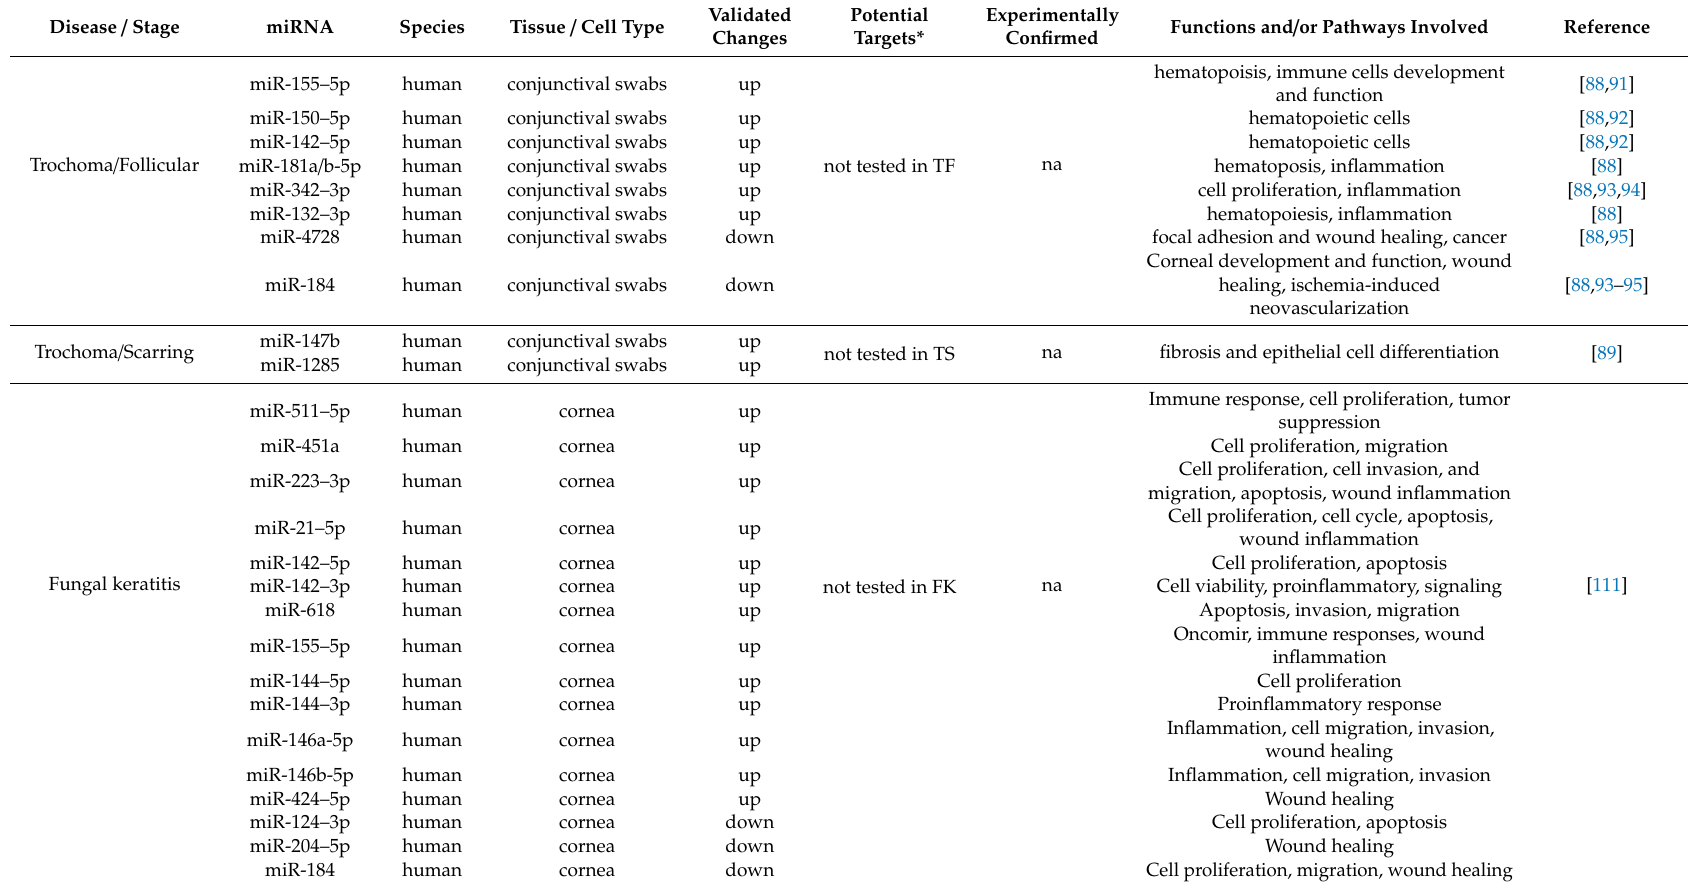
Table 1. miRNAs Involved in Ocular